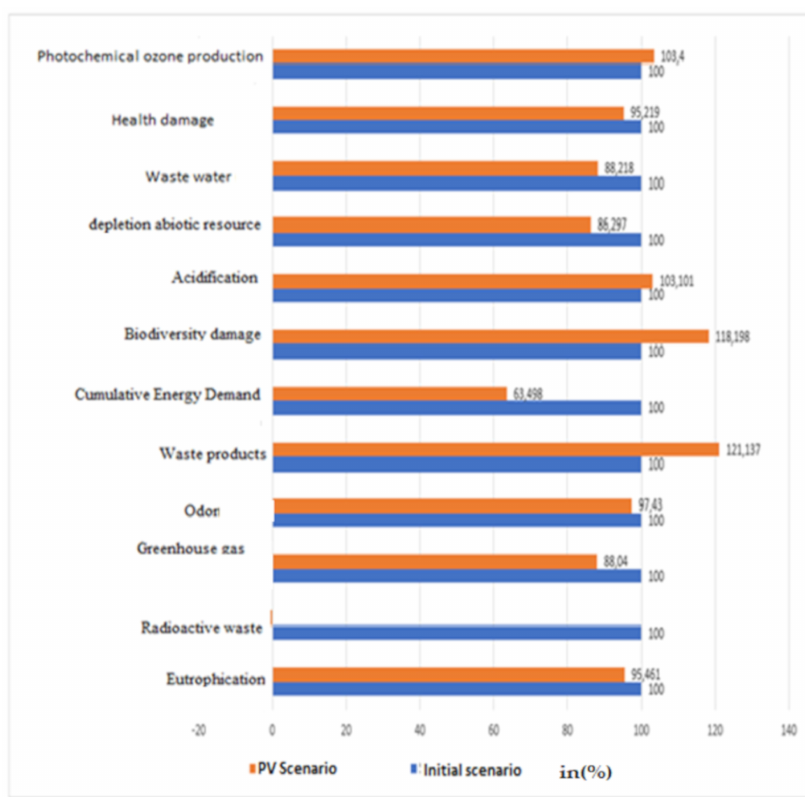
Figure 14. Comparative diagram of the environmental impacts of the “Initial” and “PV” scenarios (functional unit: entire